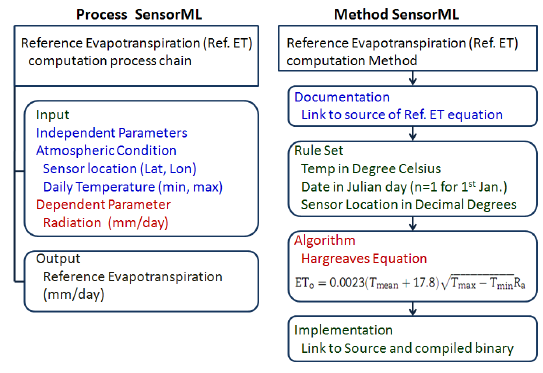
Figure 8. SensorML Process and Method for Reference Evapotranspiration